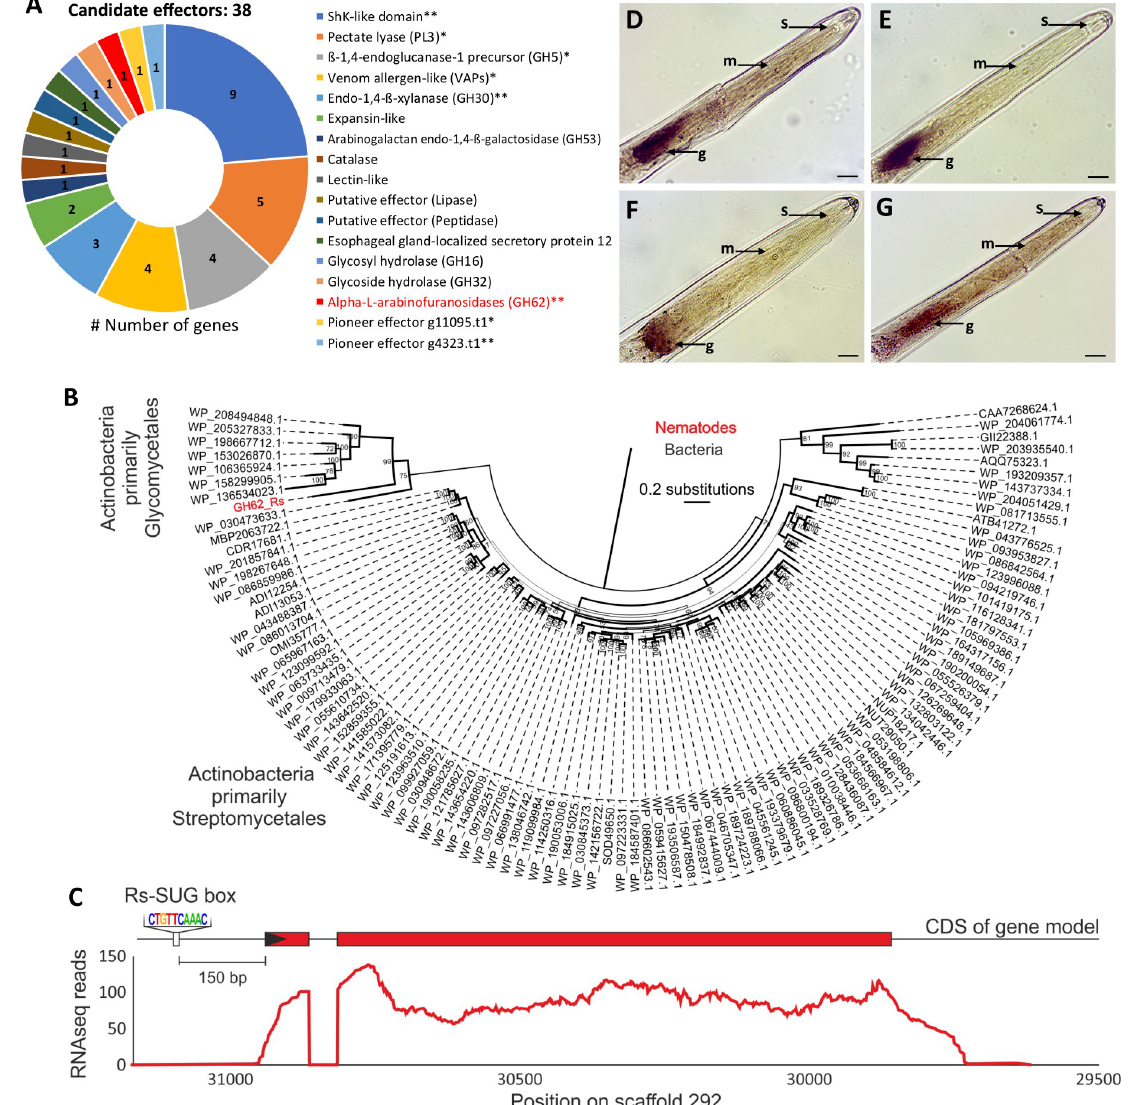
Fig 6. Identification of candidate effector genes through promoter motif searches in the genome of Radopholus similis . (A) List of candidate effector genes encoding secreted proteins without transmembrane domains identified by promoter motif CTG[T|A|C][T|G|A] CAAAC searches. (B) Maximum-likelihood phylogenetic tree of R . similis GH62 protein sequence (in red) with representative sequences retrieved from bacteria at NCBI (100 top hits). Bootstrap values are presented in the corresponding branches. (C) Graphic representation of R . similis GH62 gene model and corresponding RNAseq coverage. Exons are represented by red boxes, and signal peptide by a black arrow. (D-G) Genes associated with the Rs-SUB box coding predictive secreted proteins were localized in the nematode esophageal glands by in situ hybridization: (D) α -L-arabinofuranosidase GH62 (g448.t1), (E) endo-1,4-ß-xylanase GH30 (g15208.t1), (F) ShK-domain protein (g6688.t1), (G) pioneer gene (g4323.t1). � Validated in the esophageal glands in Fig 2. �� Validated in the esophageal glands after the Rs-SUB box identification. g: esophageal glands; m: median bulb; s: stylet. Bars = 20 μ m.